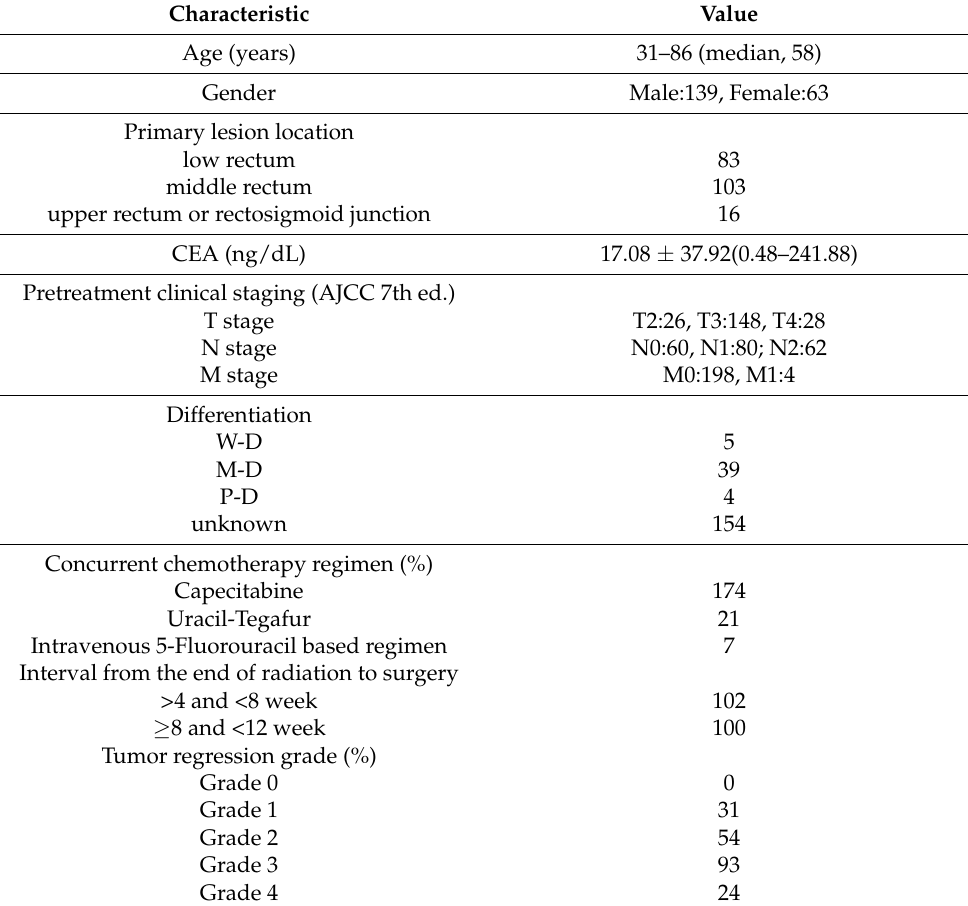
Table 1. Patient characteristics of training cohort ( n =